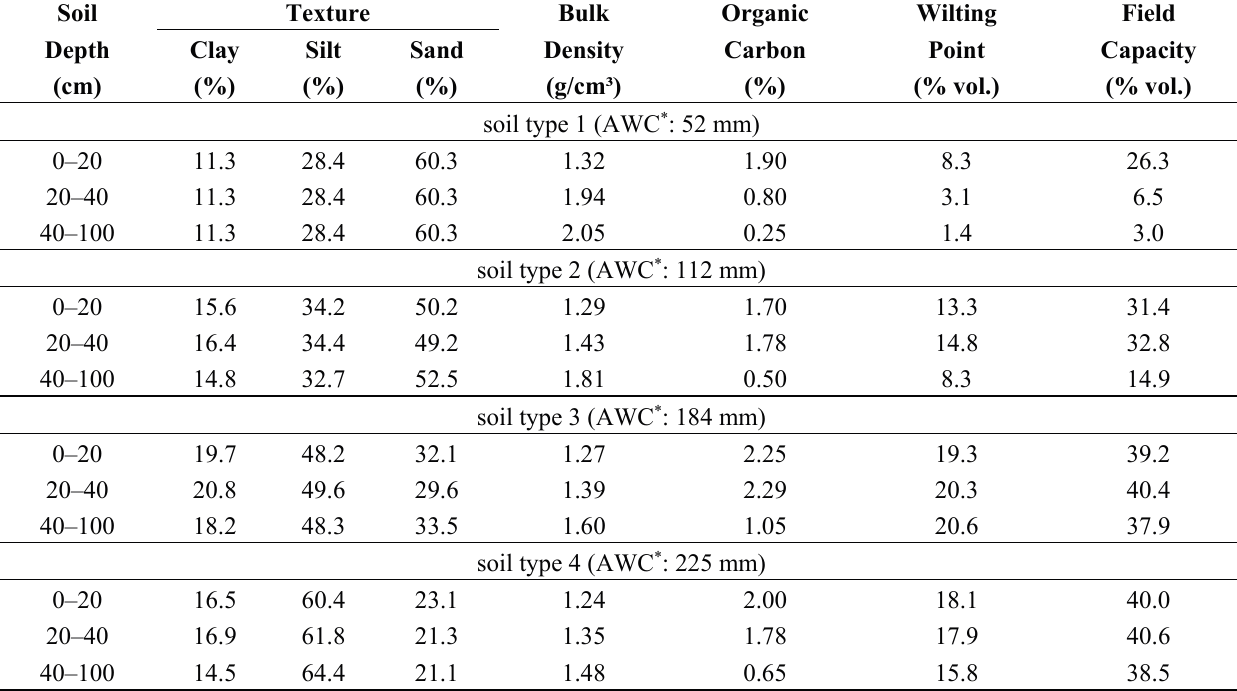
Table 5. Physical characteristics of soil types used in crop simulations for all considered